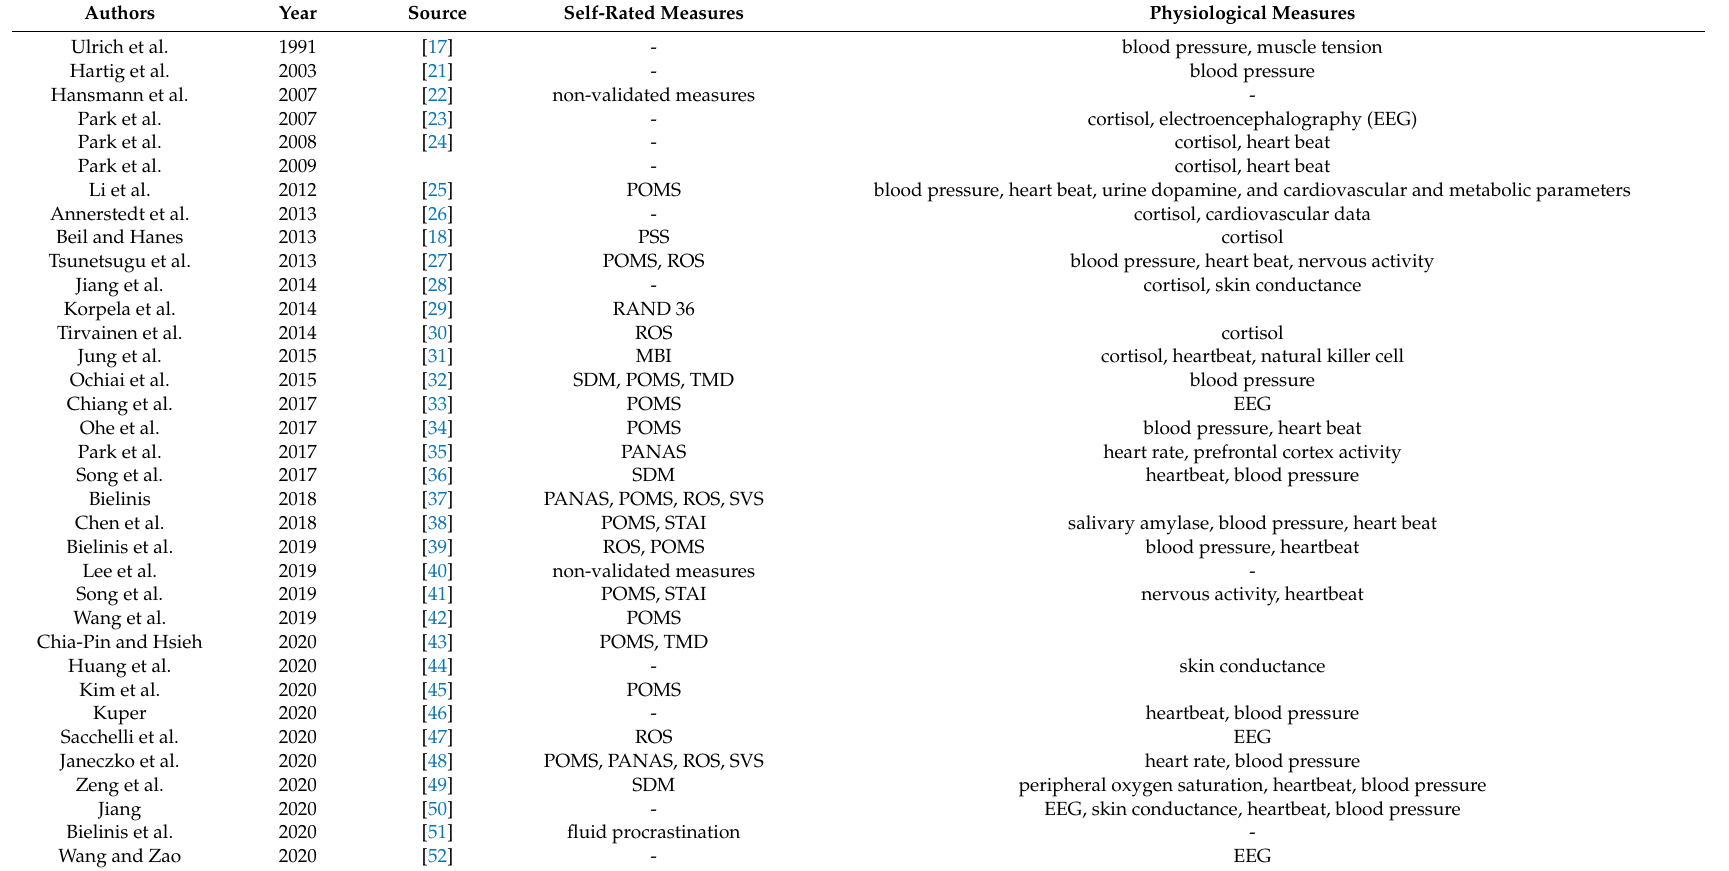
Table 2. Studies included in the